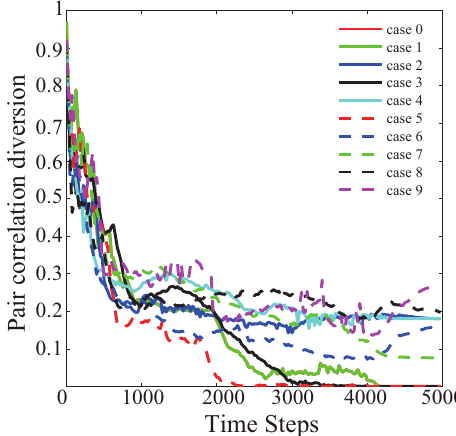
Figure 3. The pair correlation diversion as a function of time from ten independent initial distributions.